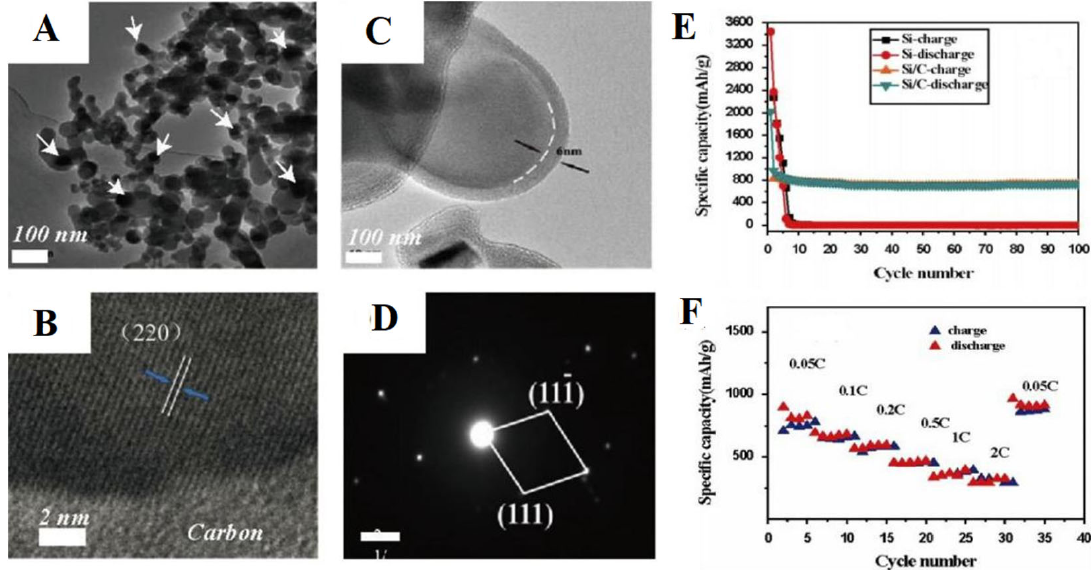
Figure 9. ( A – D ) TEM results of Si/C composite; cycling performance ( E ) and charge/discharge potentials at diverse rates ( F ) of Si/C composite. Taken with permission from [130].